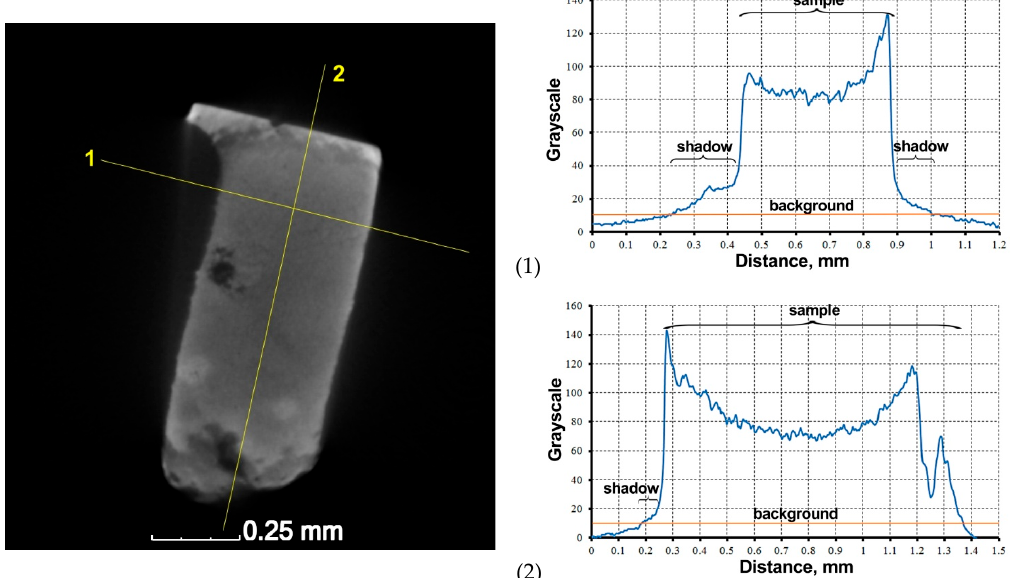
Figure 5. The projection of the sample with the expressed “shadow” from the underlaying surfaces. To obtain the correct distribution of the absorption coefficient over the section area of the sample, in addition to the background, the “shadow” was also removed; this does not lie in the analyzed projection plane (Figure 6).